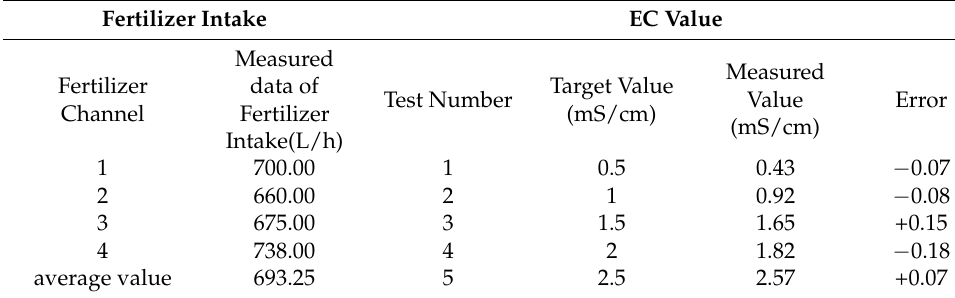
Table 8. Test results of EC regulation system for nutrient